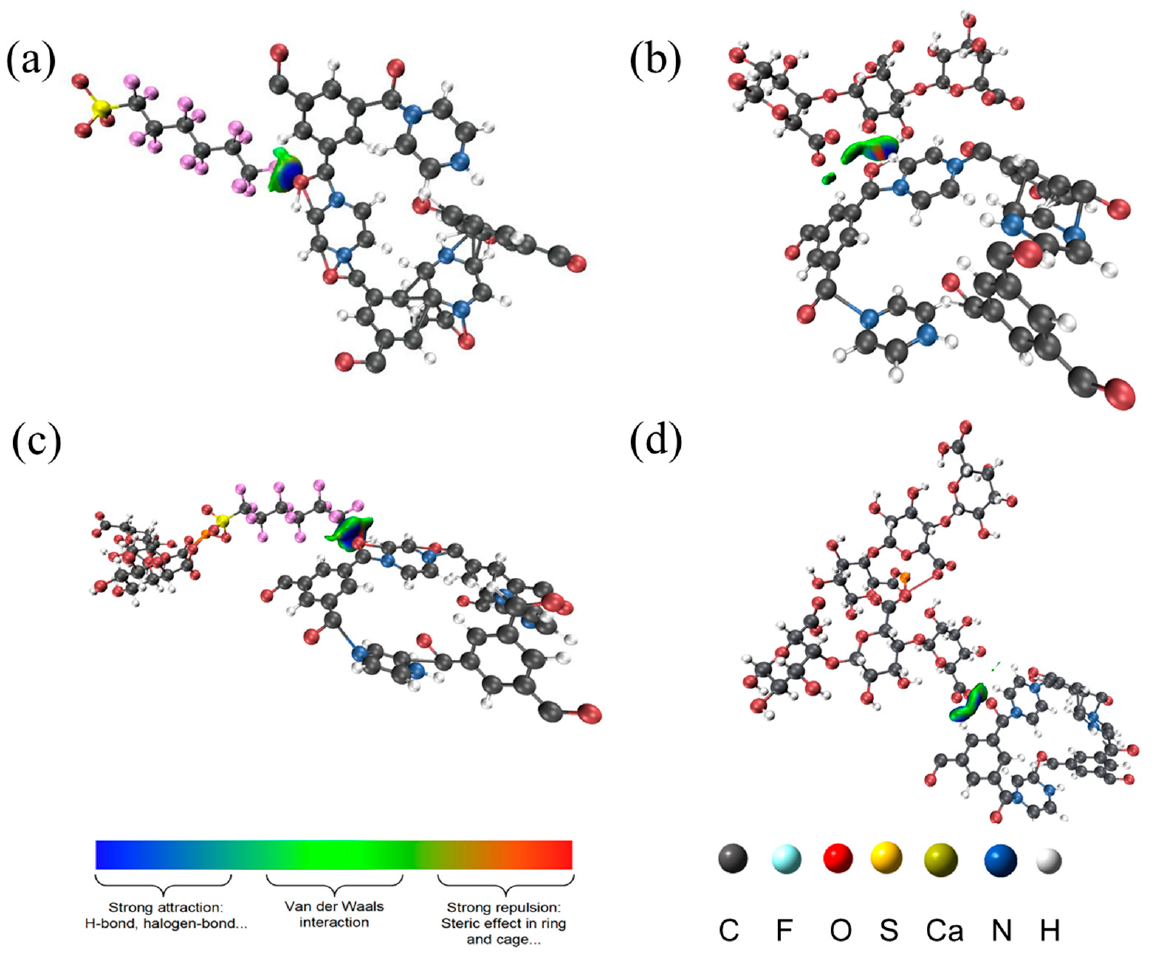
Figure 7. The schematic diagram of the interaction between contaminants and the membrane surface: ( a ) PFHxS, ( b ) SA, ( c ) PFHxS-Ca-SA, and ( d ) SA-Ca-SA. In the presence of Ca 2+ in water, Ca 2+ complexed a PFHxS molecule and a SA molecule to form a large-sized complex compound, which was intercepted by the membrane to interact with the membrane surface. Moreover, as the concentration of SA exceeded that of PFHxS, complex compounds of SA-Ca-SA were also present in the solution. As indicated by Figure 7c,d, compared with the interaction between the pollutant monomer and membrane, the hydrogen bonding between the complex compound of Ca 2+ and the pollutants, as well as the membrane, was weakened, indicating that the complexation between Ca 2+ and the pollutants produced a charge neutralization effect, which decreased the hydrogen bonding between the complex and membrane surface. As hydrogen bonding weakened, the tightness of the hydrogen bond network formed between the complex compound and the membrane surface decreased. The reason for the flux decay after adding Ca 2+ was that the powerful electrical neutralization capacity of Ca 2+ neutralized the negative charge on the membrane surface, reduced the electrostatic repulsion between SA and the membrane surface, and enhanced the adsorption capacity of SA on the membrane surface, thus forming a thicker gel layer. Moreover, given that the concentration of SA in the solution exceeded that of PFHxS, the effect on the fouling layer on the membrane surface was still much smaller than that formed by SA due to the small number of PFHxS complexes, although the tightness of the bond between the PFHxS complex compound and the membrane surface was reduced. Thus, the flux attenuation degree decreased